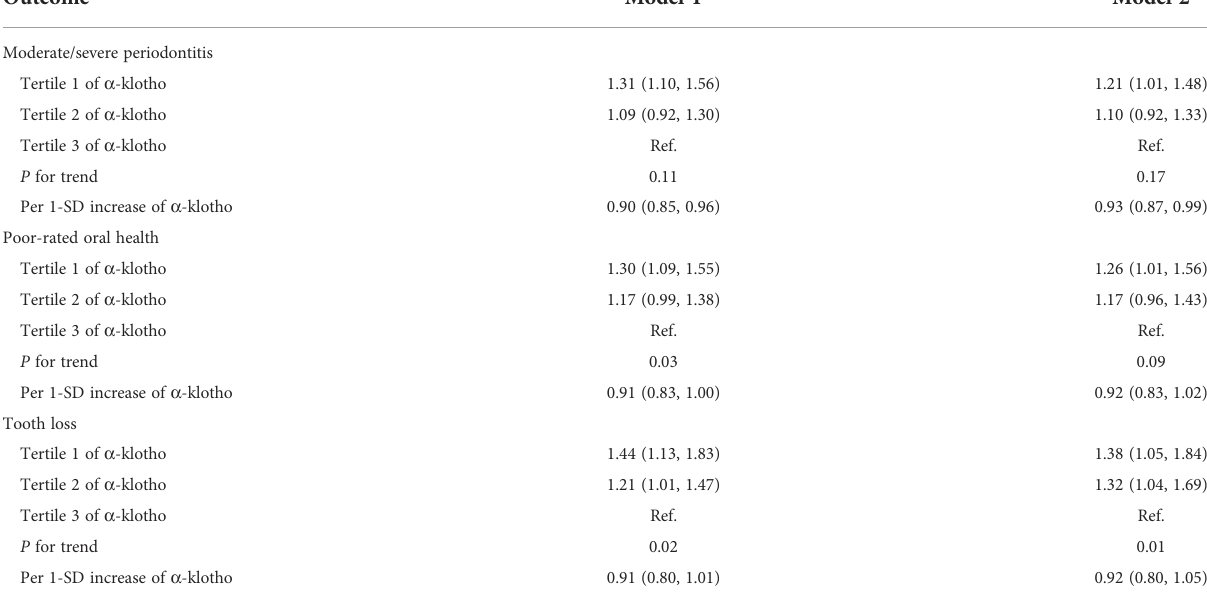
TABLE 2 Weighted ORs (95%CIs) of the association between a -klotho and oral